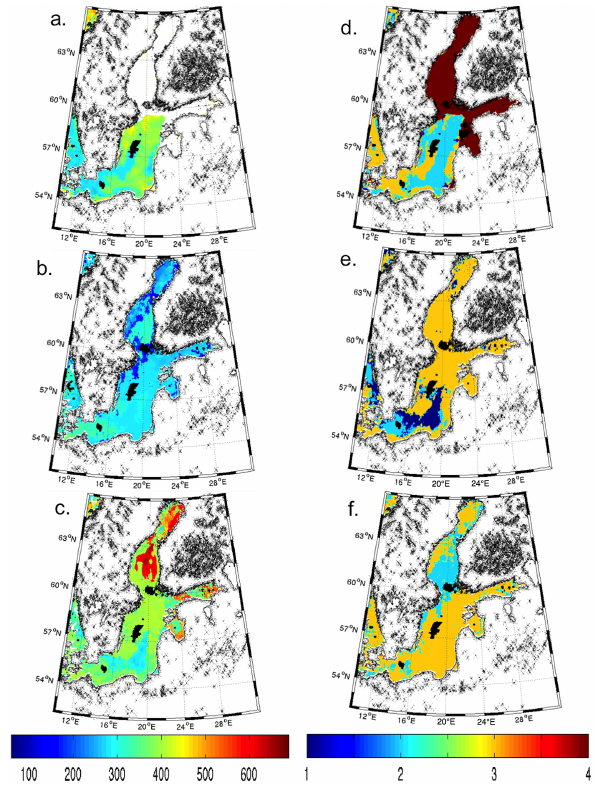
Figure 15. ( a, b, and c ) reconstruction of the p CO 2 map, ( d, e, and f ) the flag for each map. (a, d) March 2010, (b, e) July 2010, (c, f) September 2010. The flag value 1 corresponds to high confidence, 2 to medium confidence, and 3 to low confidence.